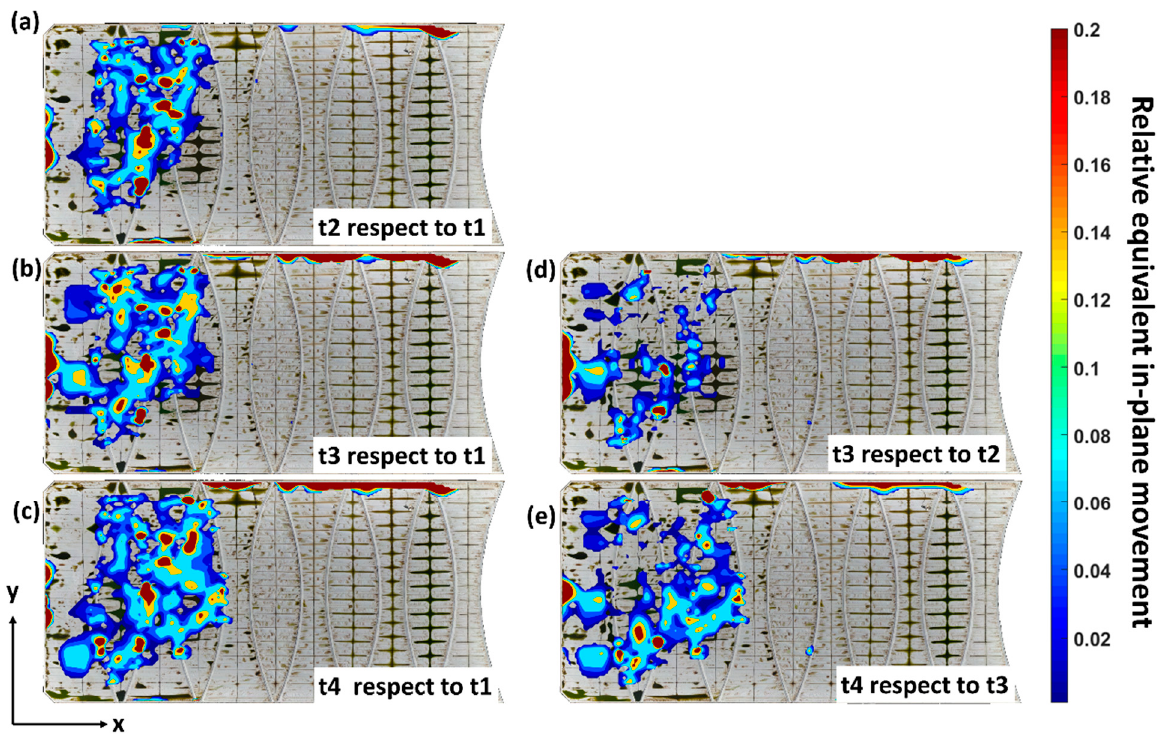
Figure 13. Relative equivalent in-plane movement for ( a ) t2 with respect to t1, ( b ) t3 with respect to t1, ( c ) t4 with respect to t1, ( d ) t3 with respect to t2 and ( e ) t4 with respect to t3.